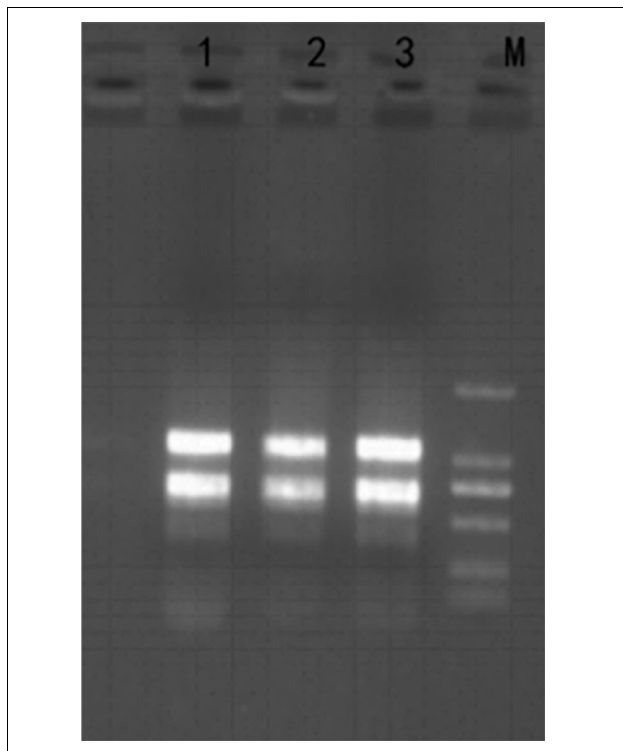
FIGURE 3 | Total RNA from H. pluvialis 192.80. Lane M was DL2000 marker, and lanes 1–3 represent three separate samples as replicates.